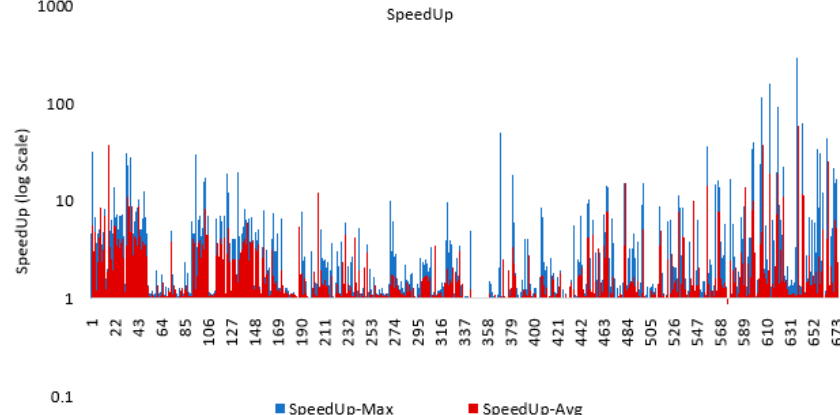
Figure 8. Speedup nnz sorted dataset (min to max).